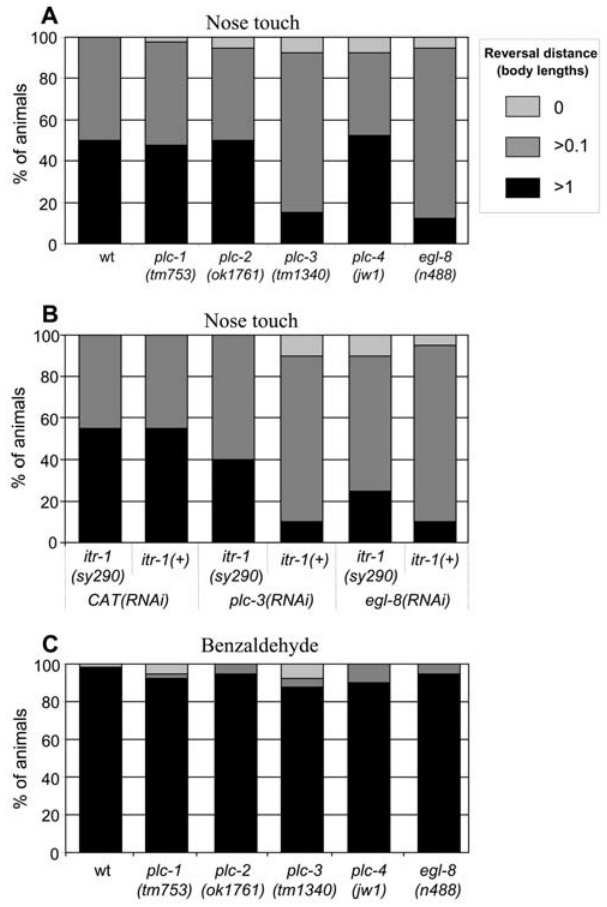
Figure 4. PLC b and PLC c function, through the production of an IP 3 signal, in the aversive response to nose touch, but not to benzaldehyde. (A) Reversal response of PLC deficient animals to nose touch. All showed a wild type response ( . 90% reversing . 1 worm length) to anterior body touch (data not shown). (B) Reversal response of itr-1(sy290) gain-of-function animals to nose touch, following depletion of plc-3 or egl-8 by RNAi. CAT, E. coli chloramphenicol acetyltransferase. All showed a wild type response ( . 90% reversing . 1